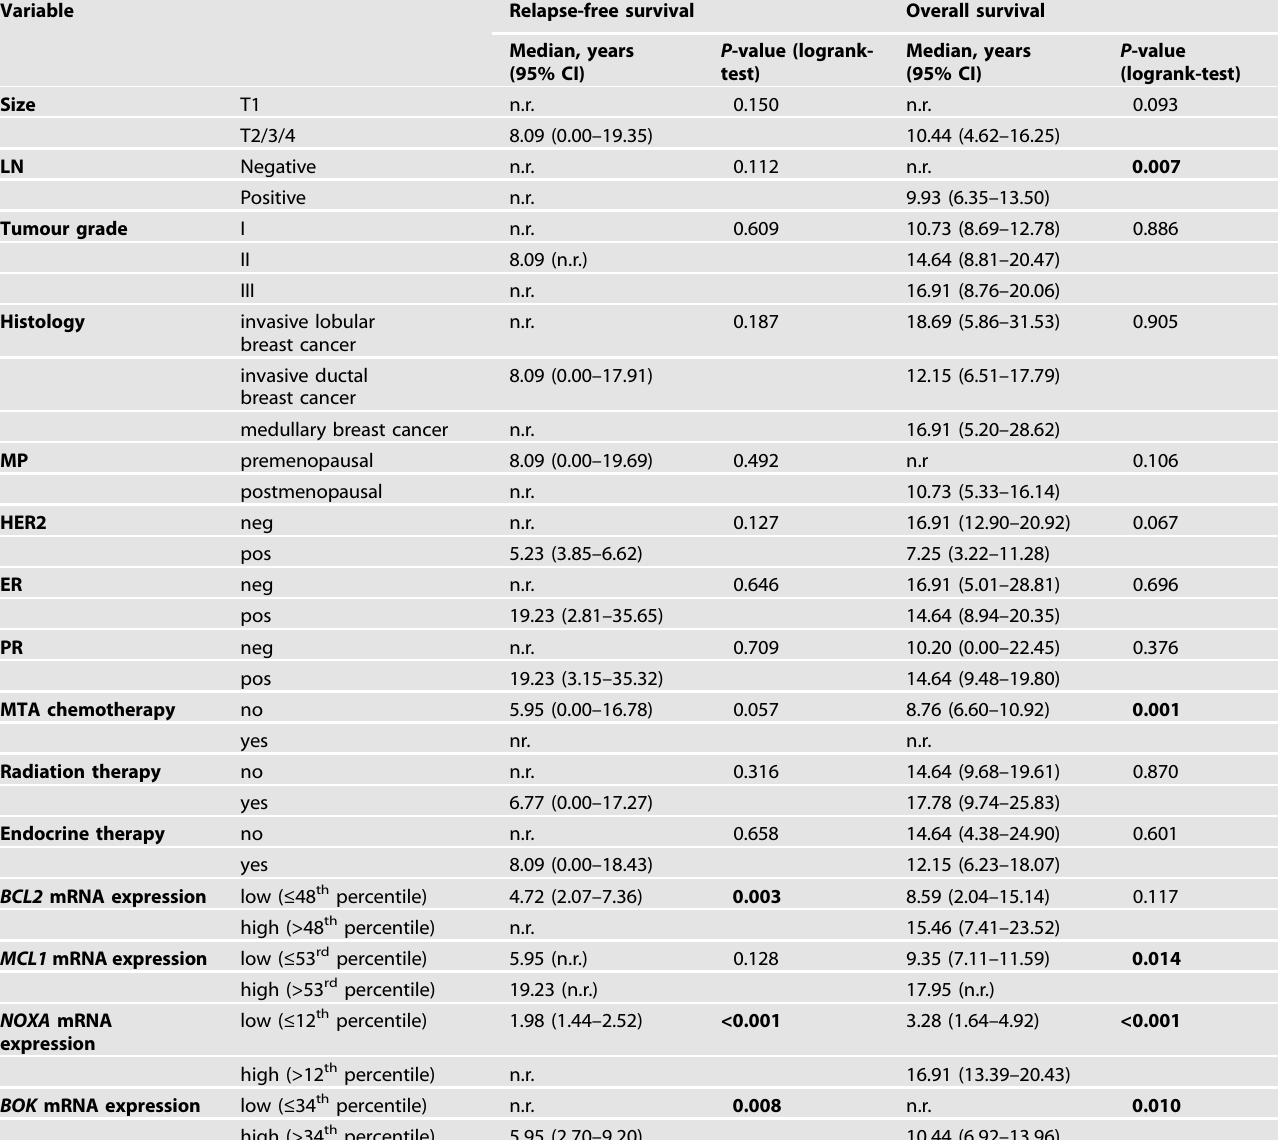
Table 1. Univariate survival analysis of relapse free and overall survival of 92 patients with primary breast cancer diagnosed and treated at the Medical University of Innsbruck, AT.